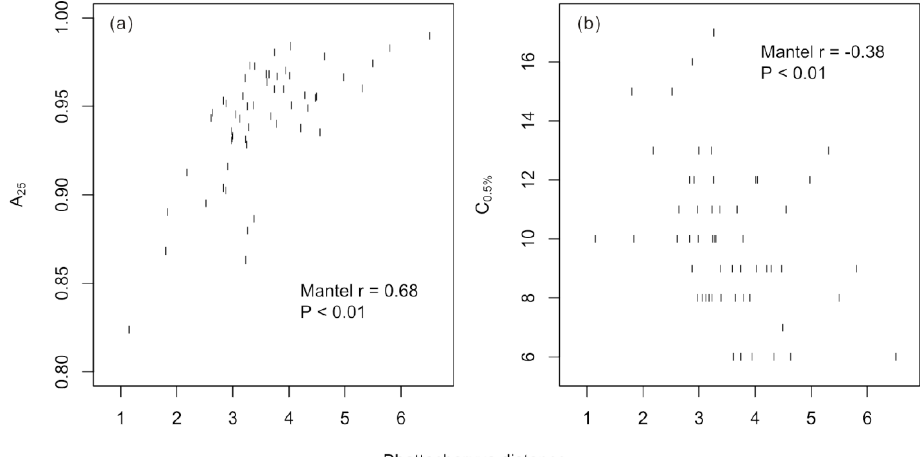
Figure 6. The relationships between the spectral dissimilarity (Bhattacharyya distance) between pairs of species and ( a ) the accuracy evaluated at 25 training crowns (A ( b ) the C of the accuracy curve for models that differentiate 0.5%